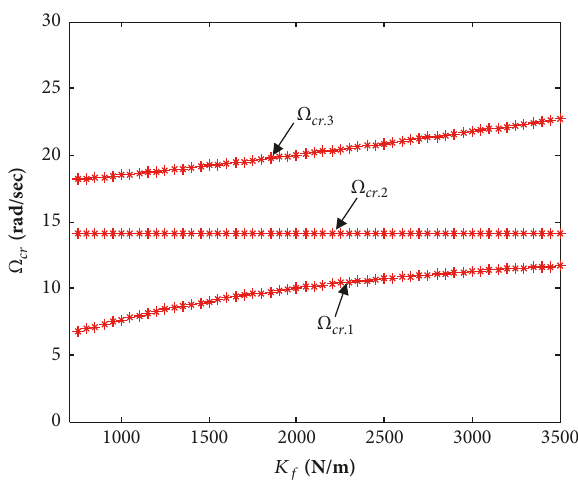
Figure 2: Natural frequencies of nominal system (without